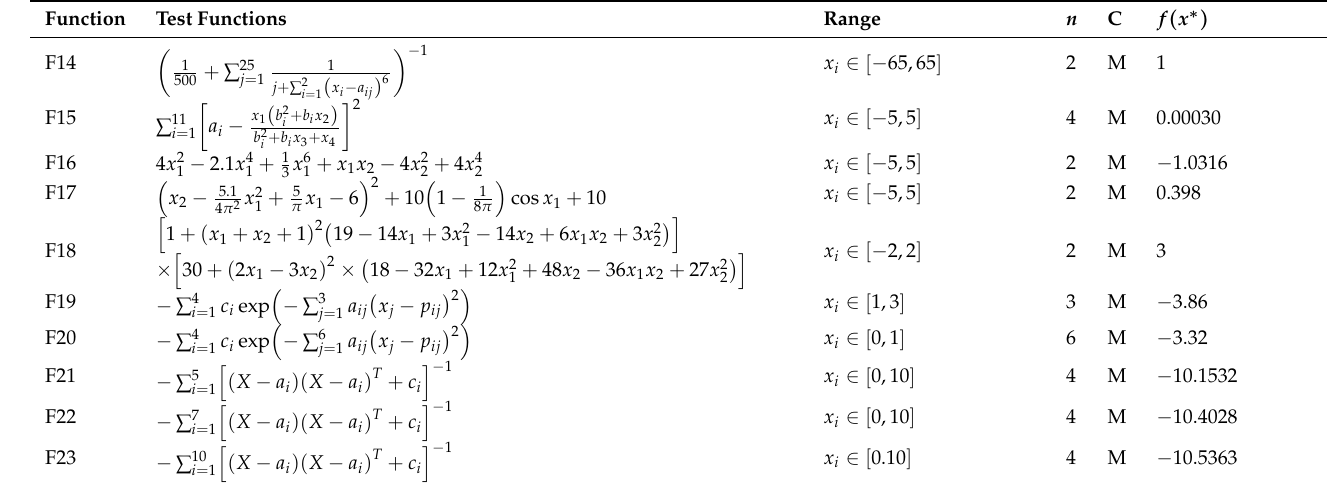
Table 4. The characteristics of fixed-dimension multimodal benchmark